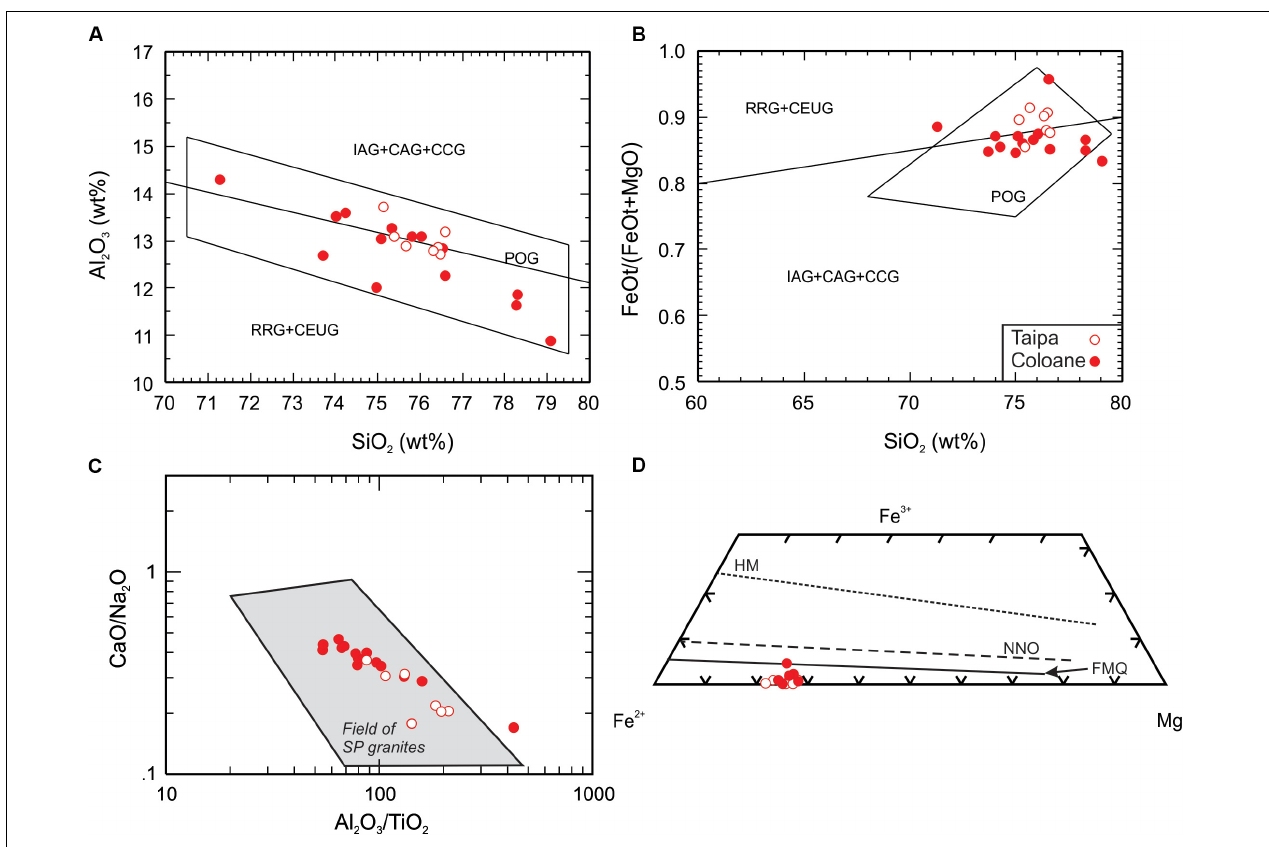
FIGURE 7 | Tectonomagmatic discrimination of granitic rocks and biotite composition redox estimates. (A) Distinction between collisional (IAG + CAG + CCG) and non-collisional (RRG + CEUG) granites using Al 2 O 3 (wt%) vs. SiO 2 (wt%). (B) Distinction between collisional (IAG + CAG + CCG) and non-collisional (RRG + CEUG) granites of Maniar and Piccoli (1989) using FeOt/(FeOt + MgO) vs. SiO 2 (wt%). FeOt, total Fe expressed as Fe 2 O 3 wt% * 0.8998. RRG, rift-related granitoids; CEUG, continental epeirogenic uplift granitoids; POG, post-orogenic granitoids; IAG, island arc granitoids; CAG, continental arc granitoids; CCG, continental collision granitoids. (C) CaO/Na 2 O vs. Al 2 O 3 /TiO 2 classification of strongly peraluminous granitic rocks. (D) Composition of biotite from the Taipa and Coloane leucogranites express in the Fe 2 + -Fe 3 + -Mg diagram from Wones and Eugster (1965). FMQ, fayalite-magnetite-quartz buffer; NNO, Ni-NiO buffer; HM, hematite-magnetite-buffer.